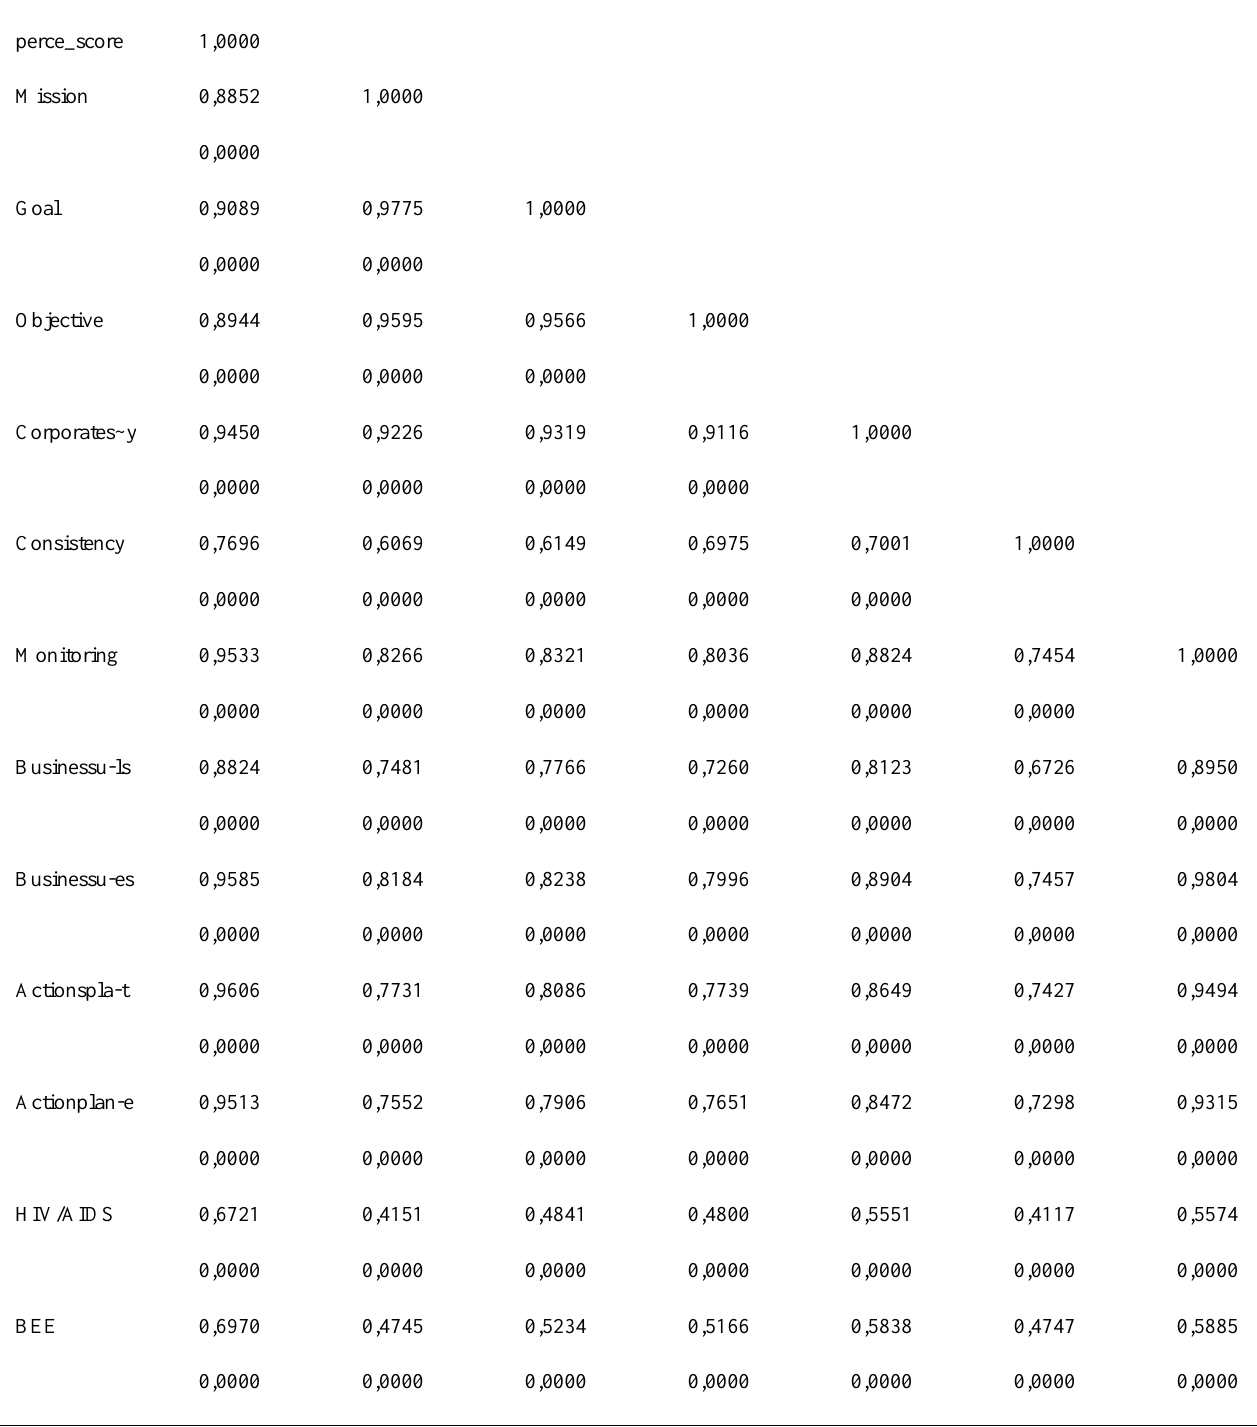
Table 4: Per cent statistical